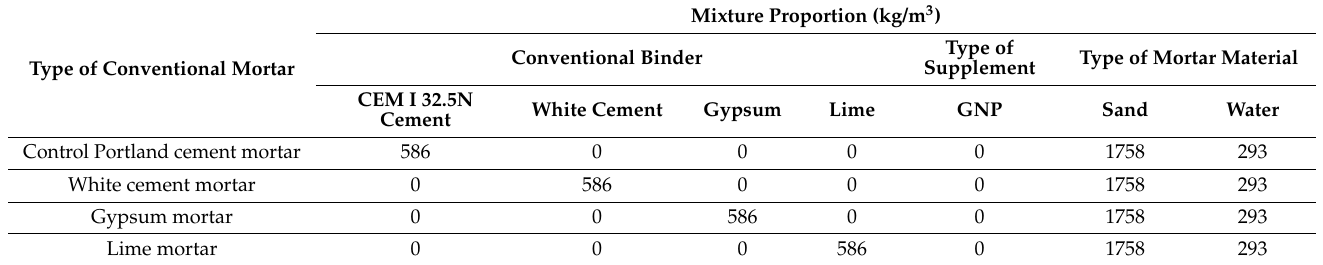
Table 1. Mixture proportions (kg/m 3 ) of conventional mortars.